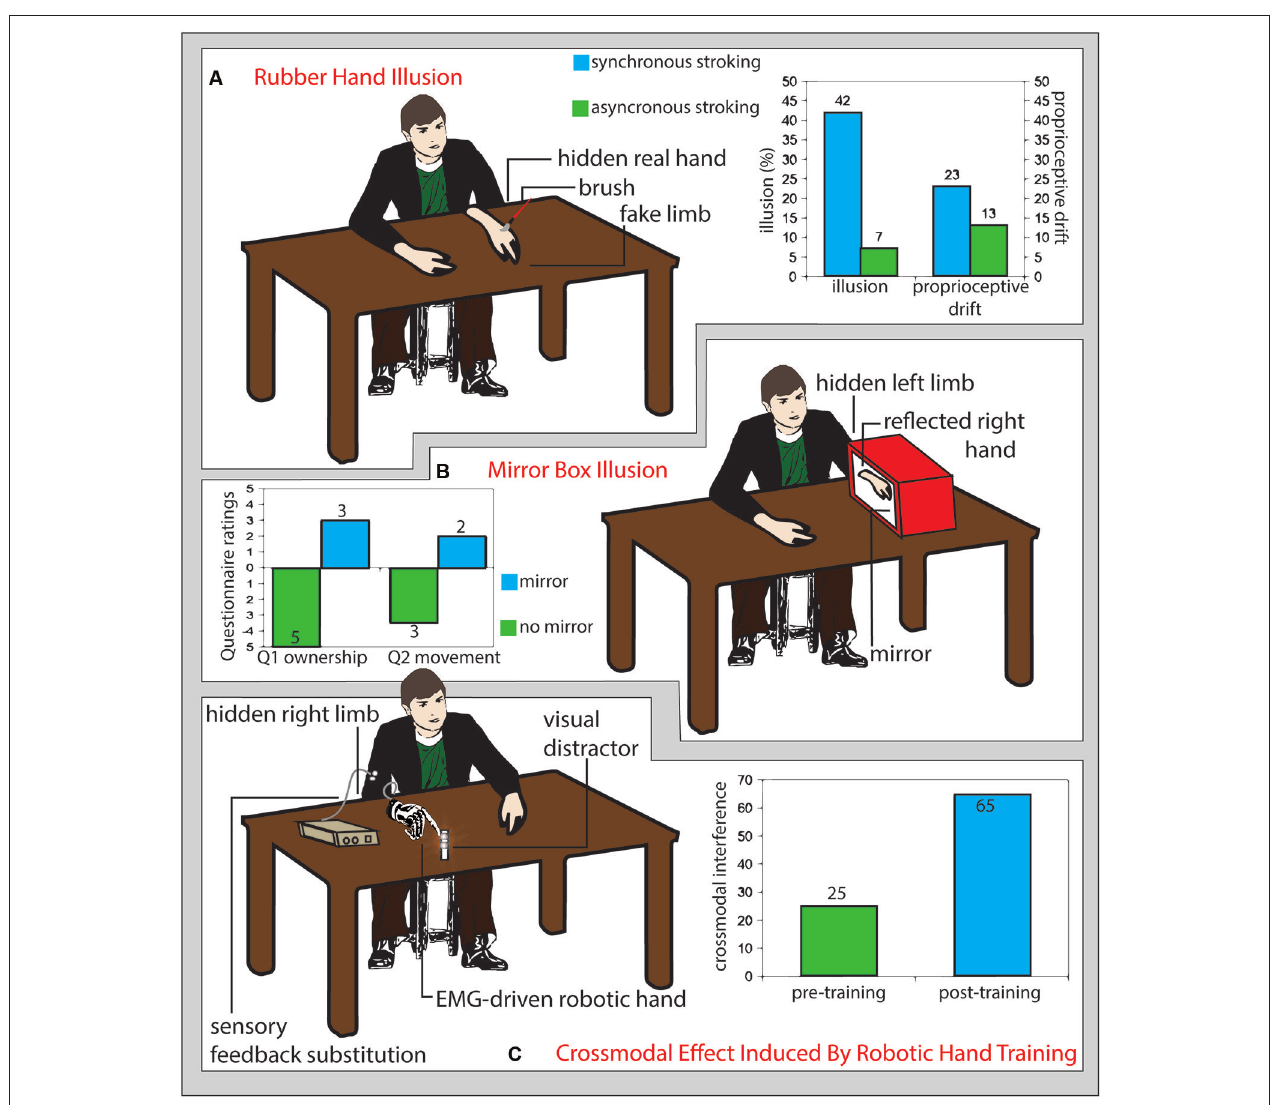
ownership (Question 1: “The reflection in the mirror looks like the hand behind the mirror”, left panel, left light blue column) and inducing the illusion of apparent movement (or a true, involuntary, unconscious movement) of the hand inside the box (Question 2: It seems as though the hand behind the mirror is moving; left panel right light blue column) (Romano et al., 2013). (C) Crossmodal effects induced by robotic hand training. Prolonged use of an electromyography-driven, detached robot hand (drawn in gray on the right side of the table) providing sensory feedback referred to the participant’s arm (white circles), increased the interference from visual distracter leds located near the robot hand fingers (reddish shadowed circles) tested with the crossmodal congruency paradigm (right panel, light blue columns), as compared to the pre-training assessment (right panel, green columns). This pattern of results suggests a training-dependent expansion of crossmodal integration properties, typical of the peripersonal space near the body, to the space surrounding the robot hand (Marini et al.,